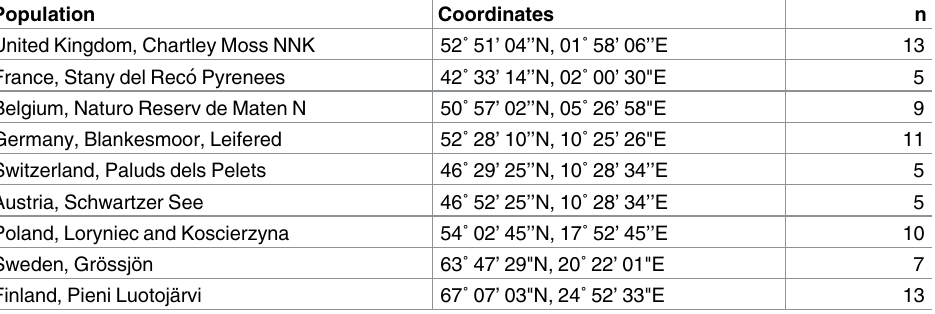
Table 1. Name and coordinates of locations sampled, n denotes number of individuals sampled. The sample from Polandis a pooledsample from four localities treated as one population(54˚02’45’’ N